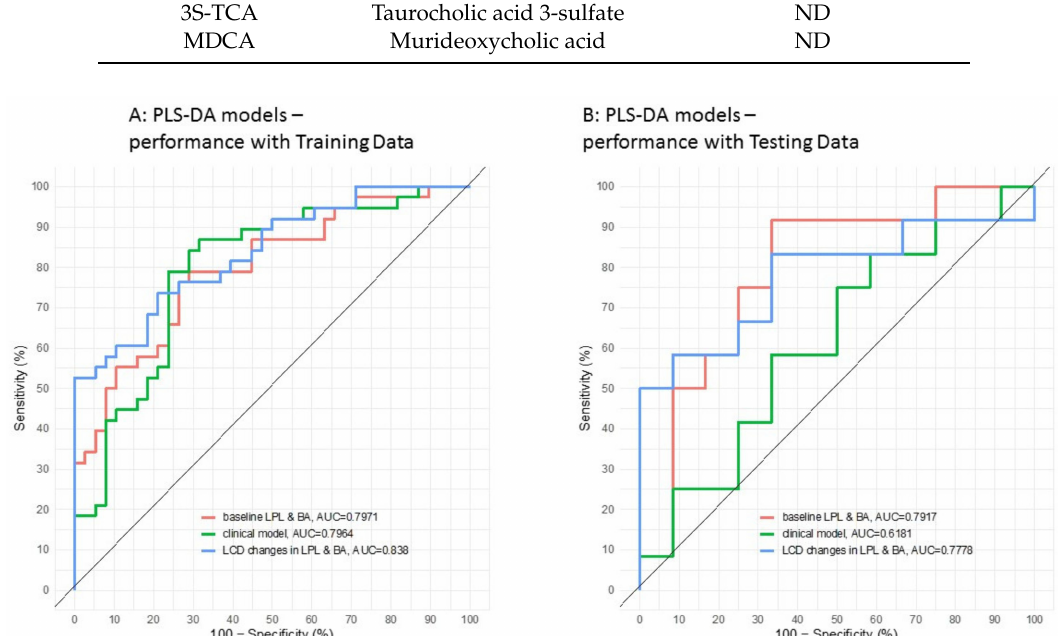
Figure5. ReceivingOperatingCurves(ROC)usedtopredictweightlossrespondersandnon-responders. ( A ) Performance for the training set, and ( B ) performance for the testing